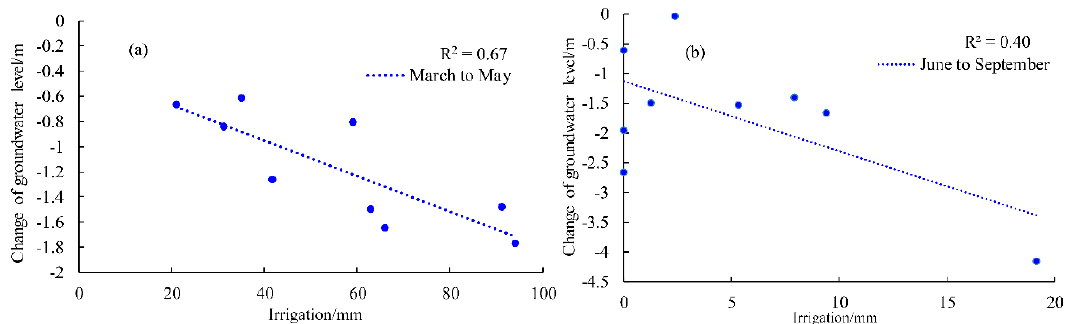
Figure 10. Correlation between the groundwater withdrawal for irrigation and the change in the groundwater level ( a ) March to May ( b ) June to September.